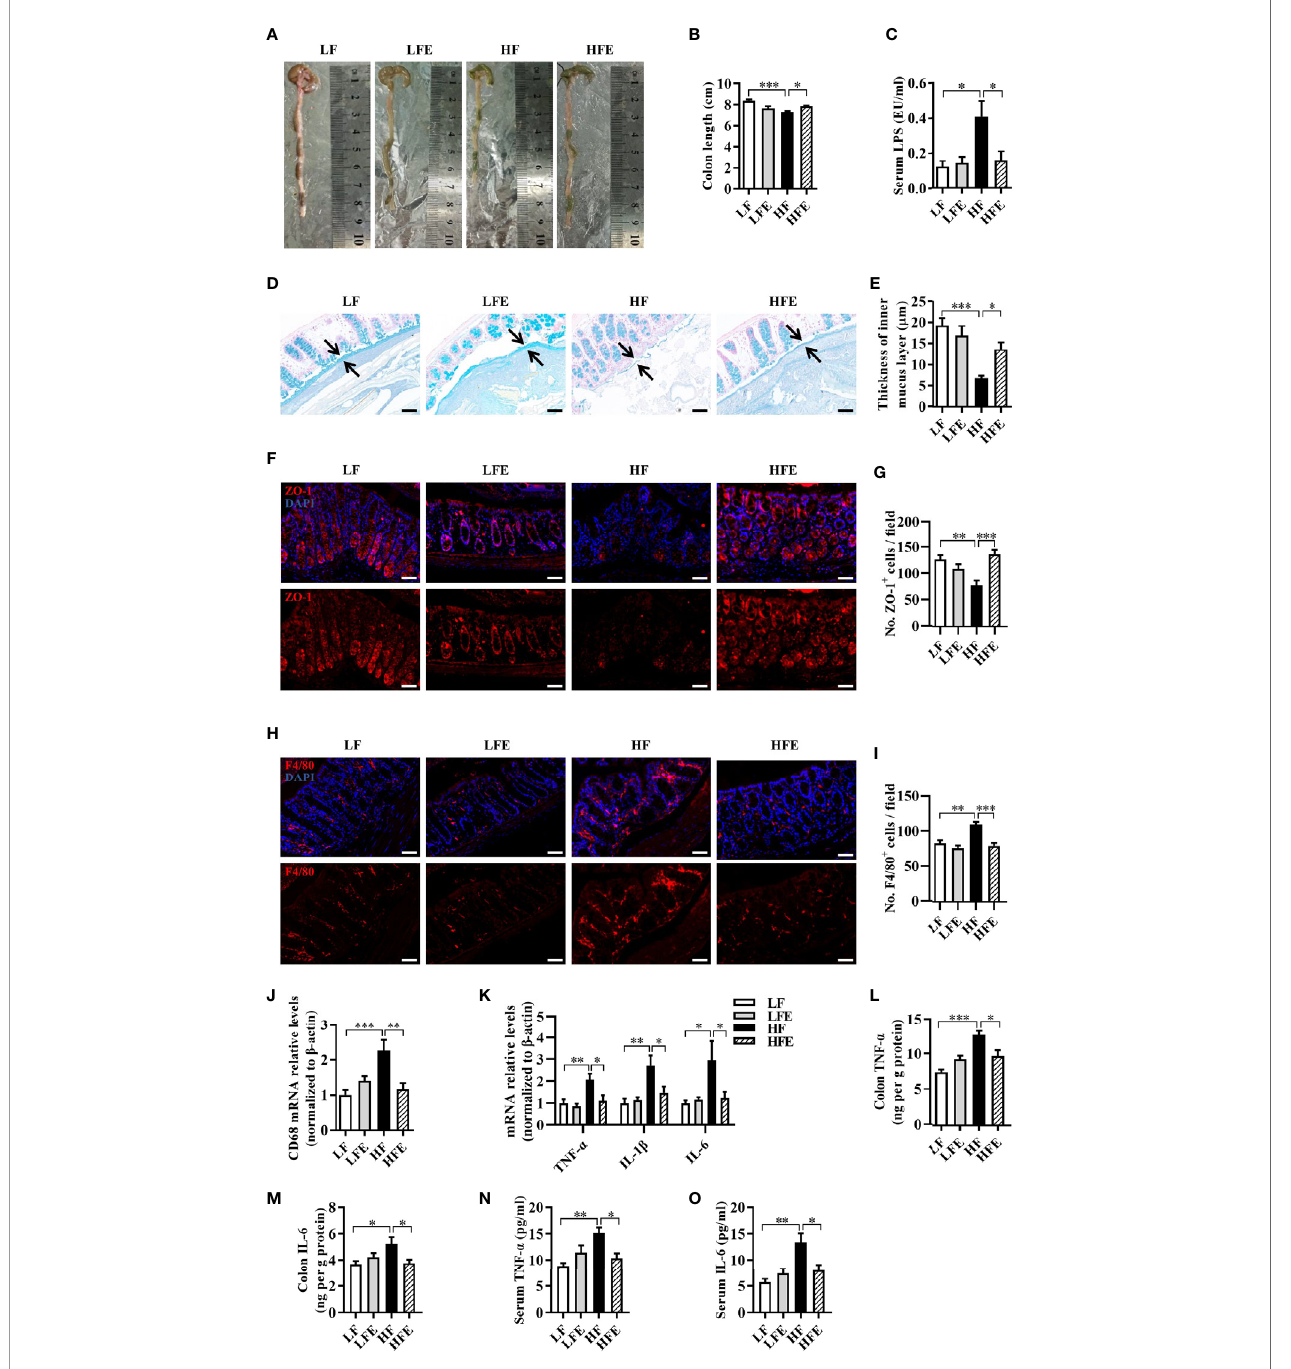
FIGURE 4 | ESPs supplementation prevented mucosa barrier impairment and in fl ammation in the colon of HF diet-induced obese mice. (A) Representative images of the colon. (B) Statistical results of colonic length (n = 12). (C) Level of lipopolysaccharides (LPS) in the serum. (D) Representative images of the Alcian blue-stained colonic sections (scale bar 50 m m), showing the mucus layer (arrows). Opposing black arrows with shafts delineate the mucus layer measured. (E) Quanti fi cation of the colonic mucus layer was statistically analyzed (n = 3, 2 images per section, 2 sections per mouse). (F) Representative immuno fl uorescence images of the colonic sections stained with the zonula occludens-1 (ZO-1) antibody and 4 ’ , 6-diamidino-2-phenylindole (DAPI). (G) Statistical results of ZO-1 positive cells/ fi eld (n = 3, 2 images per mouse, scale bar 50 m m). (H) Representative immuno fl uorescence images of the colonic sections stained with the F4/80 antibody and DAPI. (I) Statistical results of ZO-1 positive cells/ fi eld (n = 3, 2 images per mouse, scale bar 50 m m). (J, K) The mRNA expression levels of CD68 (J) and proin fl ammatory cytokines (K) in the colon of mice (n = 5-6). The relative mRNA levels were normalized with reference gene ( b -actin). (L – O) The levels of TNF- a and IL-6 in the serum and colon (n = 6). Values are represented as mean ± SEM. * P < 0.05, ** P < 0.01, *** P < 0.001. Tukey-Kramer